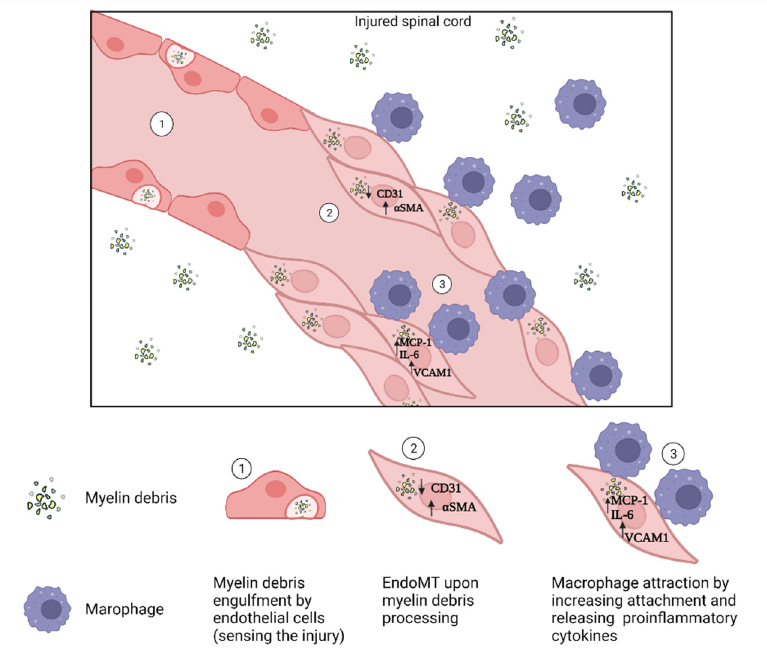
Figure 2. Role of endothelial cells in neuroinflammation in SCI lesions. Upon SCI, ongoing de- myelination of axons causes the persistent presence of myelin debris in the injury area. Endothelial cells sense the injury and engulf the myelin debris, resulting in EndoMT. These endothelial cells secrete inflammatory factors that induce macrophage infiltration and attachment, promoting neu- roinflammation. This image was created with BioRender.com (accessed on 29 July